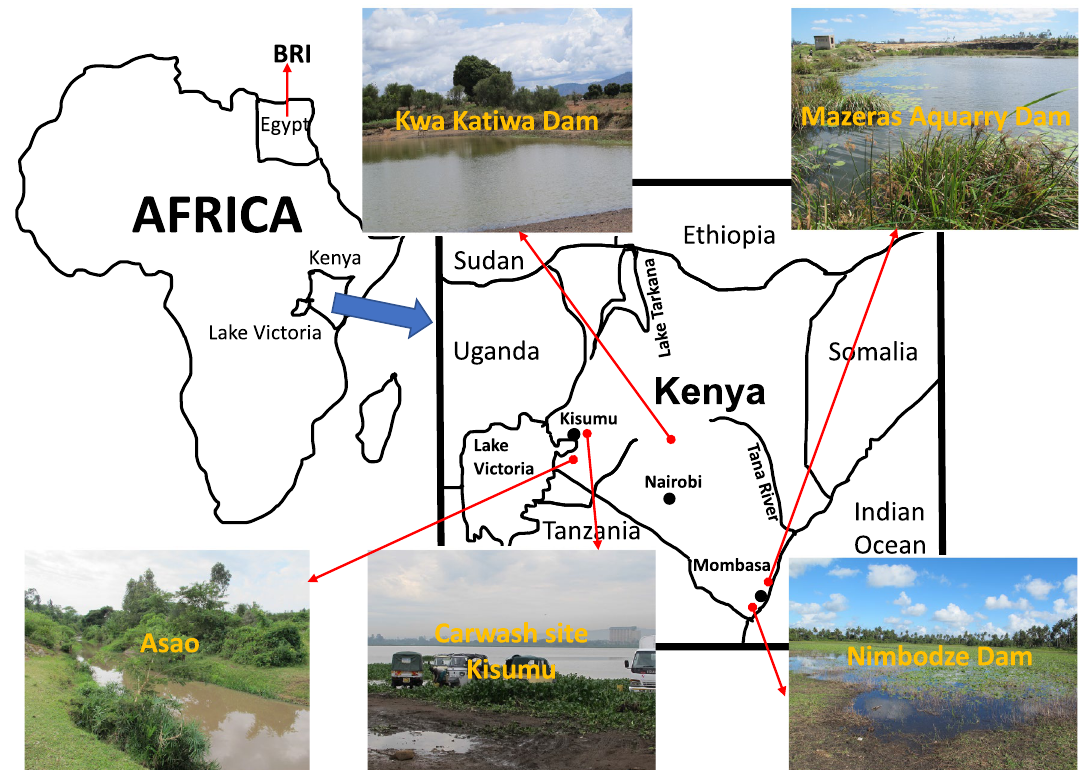
Figure 5. Localities of snail samples used for the study. The maps were drawn by the first author S-MZ and photos were taken by